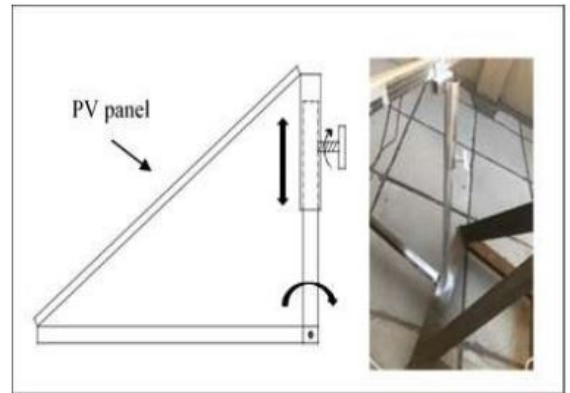
Figure 4. PV panel supported frame